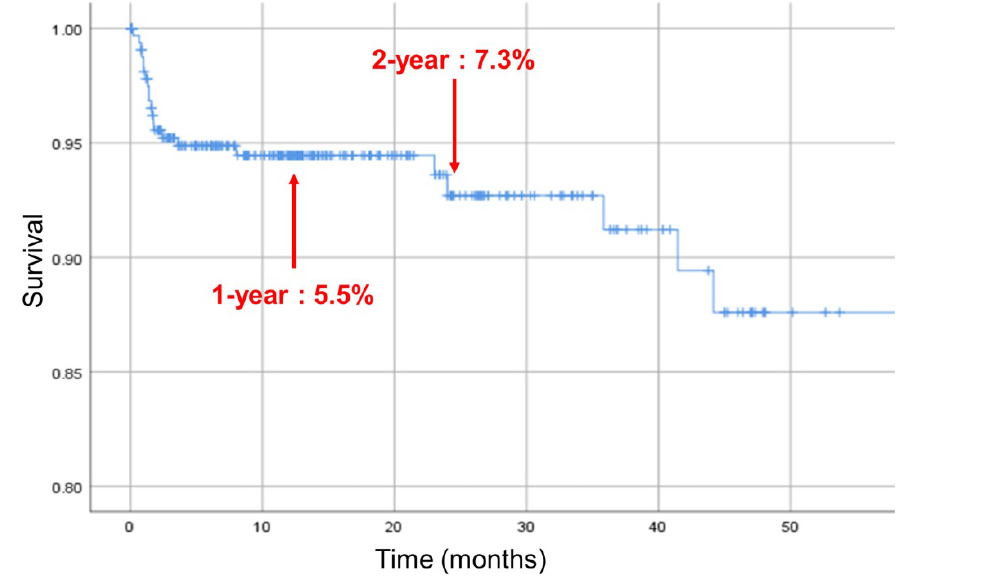
Figure 2. Kaplan-Meier survival curve. Vertical marks indicate